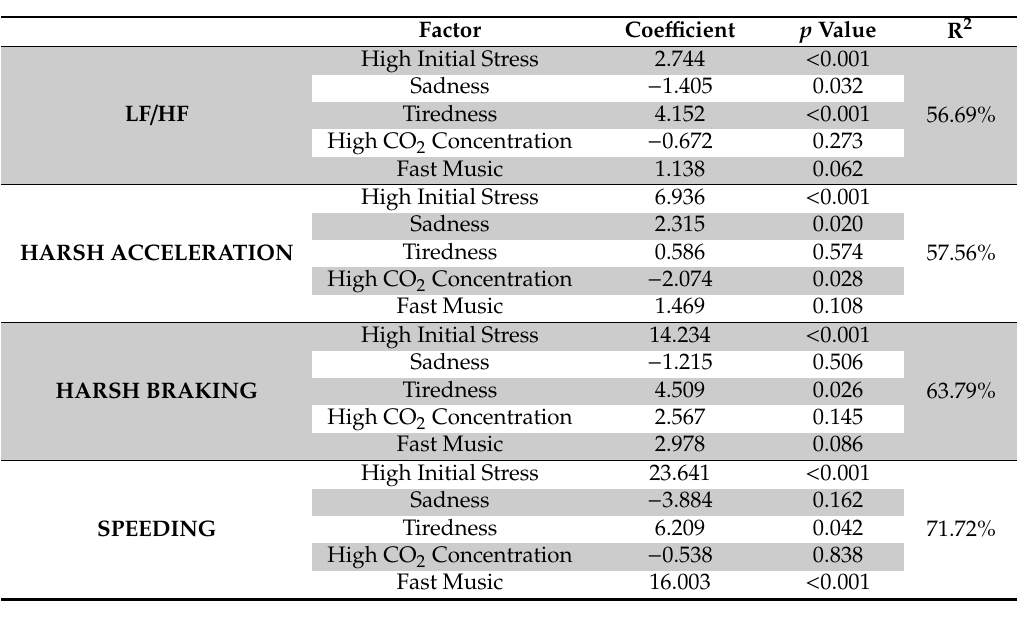
Table 16. Results of multivariate analysis with high R 2